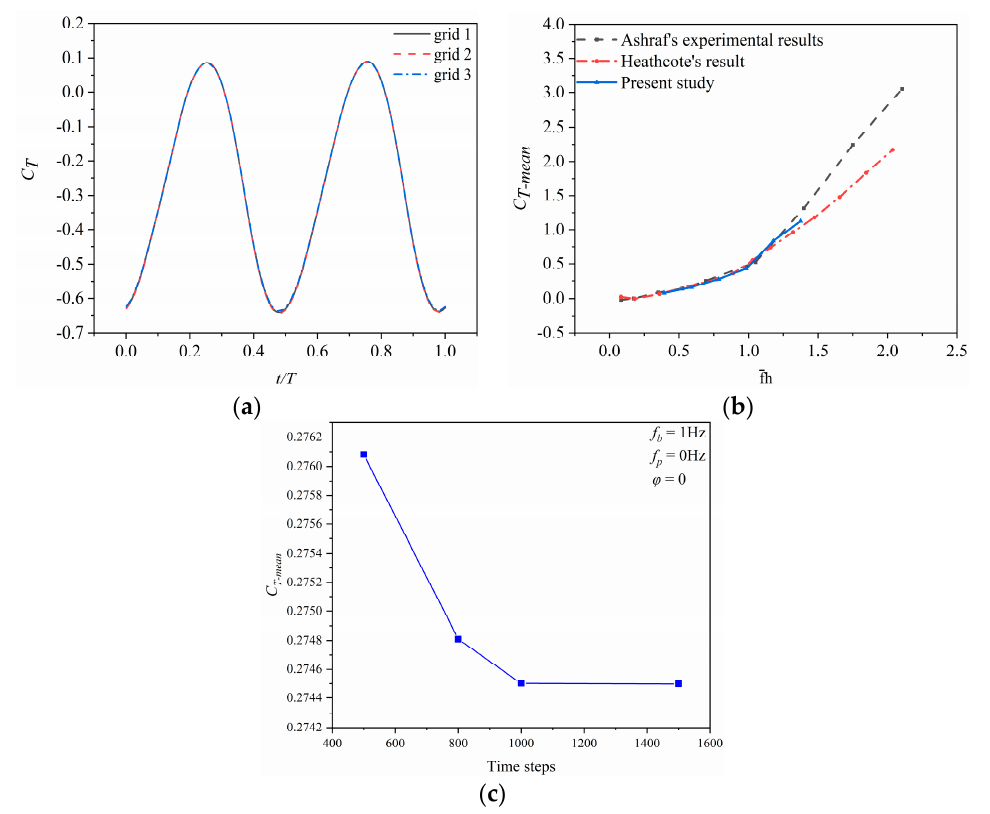
Figure 3. Validation for present numerical simulation: ( a ) grid independence verification, ( b ) calcu- lation method validation and ( c ) validation for present numerical simulation.